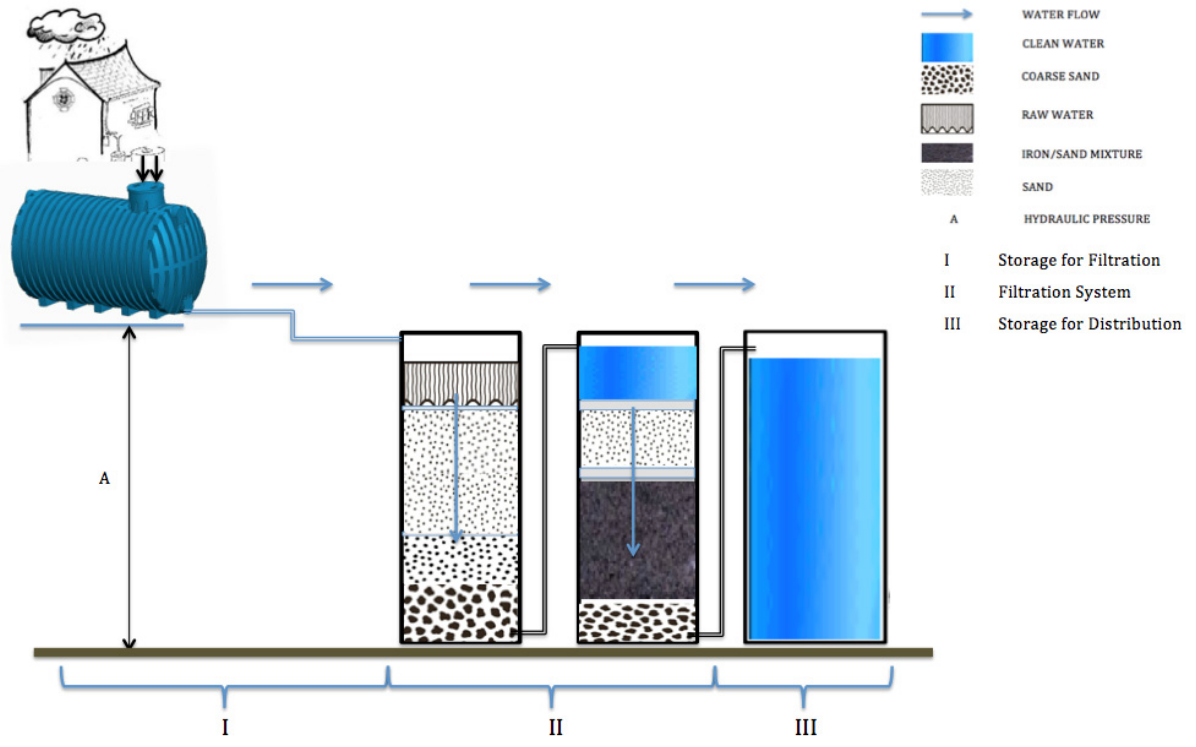
Figure 1. Concept of water treatment train based on filtration on granular materials and including at least one sand filter for media filtration (roughing filter). Further units may comprise: (i) biosand filter; (ii) activated carbon filter, Fe 0 /sand filter. Treated water is stored for